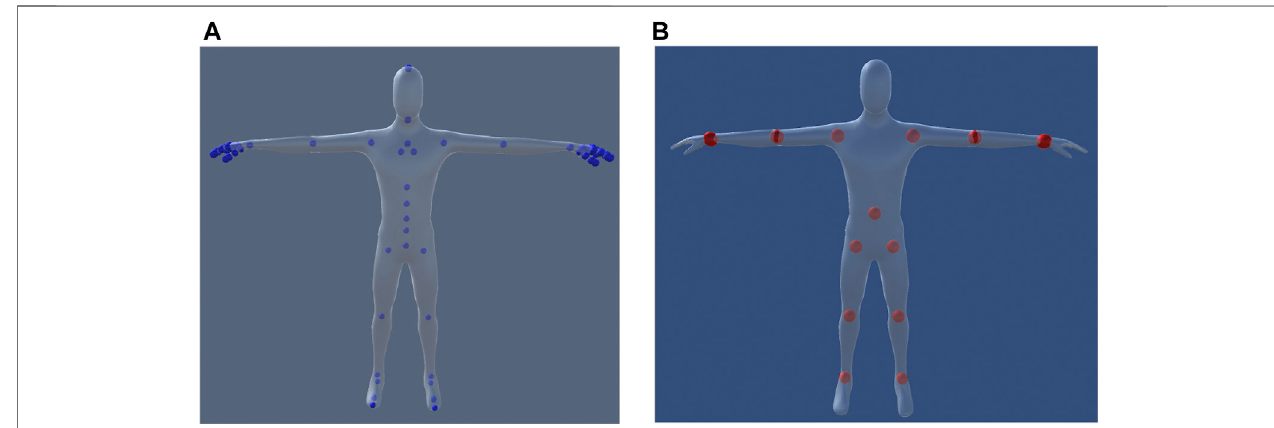
FIGURE 5 | The human model in the DHM-based simulation module. (A) The position of each bone (B) The 13 joints used for inverse kinematics.